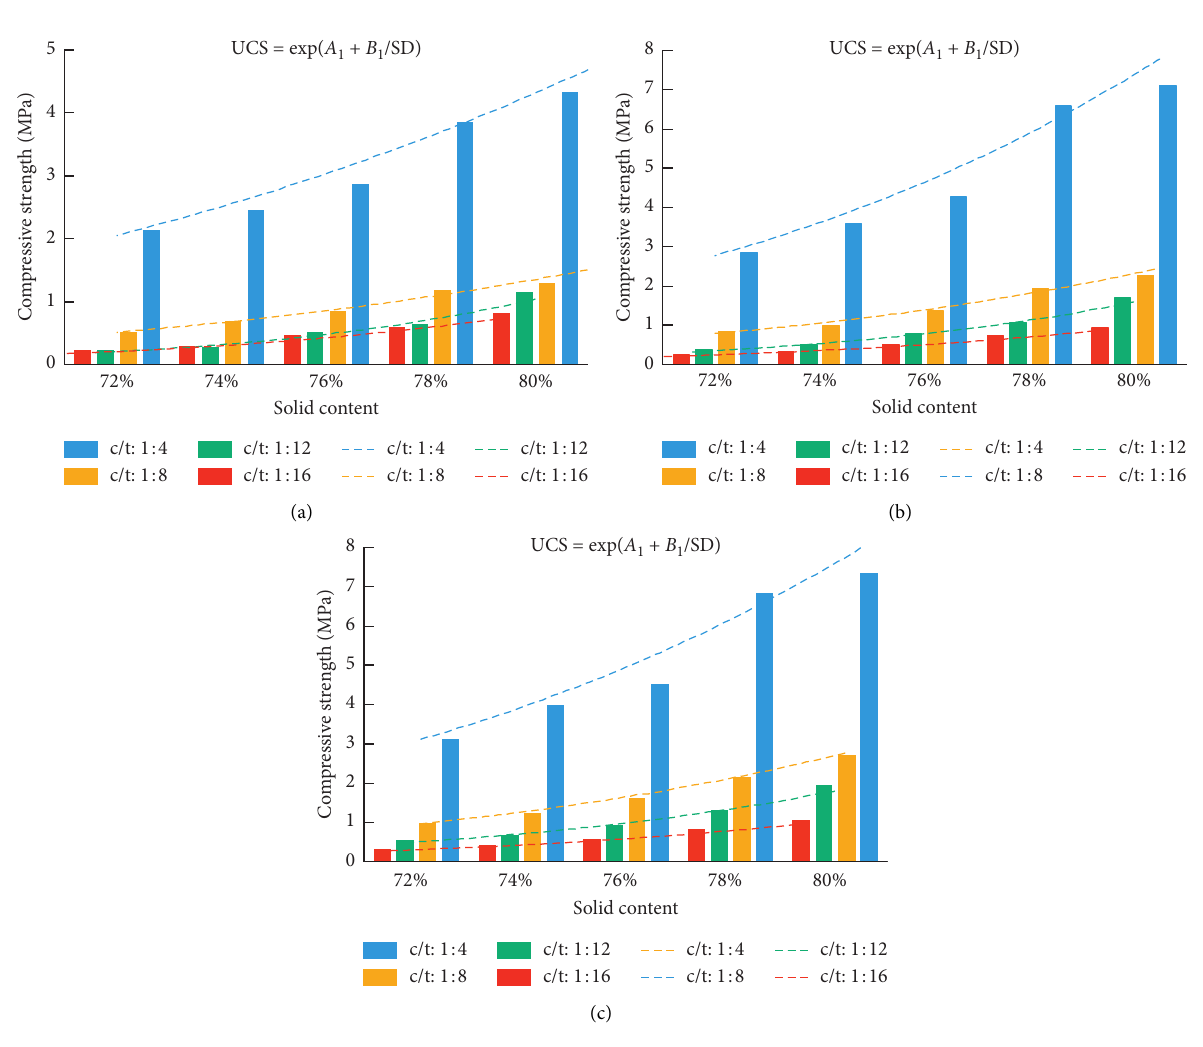
Figure 7: Relationship between SD and UCS of CUTB: (a) CT :7d; (b) CT: 28d; (c) CT: 56d. Table 14: UCS results of CUTB samples under various SDs.